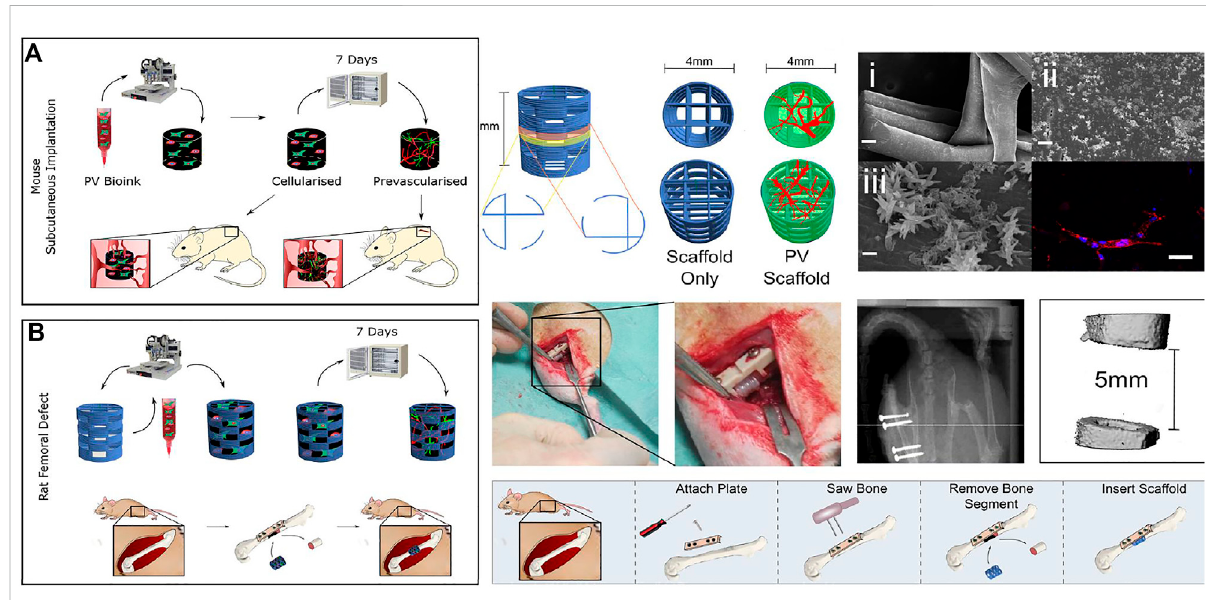
FIGURE 5 The fi brin-based hydrogel was applied with the HUVEC microvessel network in bio printing for bone regeneration with application in subcutaneous tissue (A) and femoral defect (B) in mouse. Bioink was combined with HUVECs and supporting human bone marrow stem/stromal cells (hBMSCs). Reproduced with permission from ref (Nulty et al.,